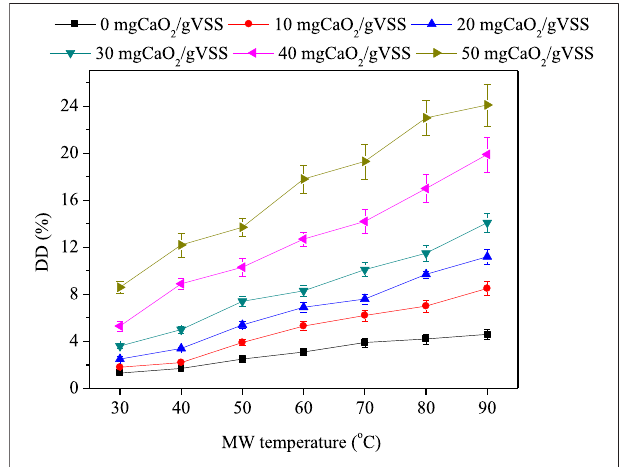
FIGURE 1 | Effect of microwave temperature and CaO 2 dosage on capillary suction time.